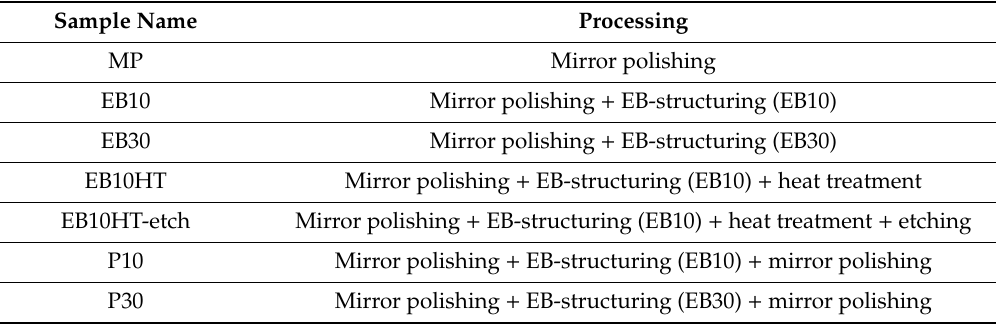
Table 1. Ti6Al4V sample names and